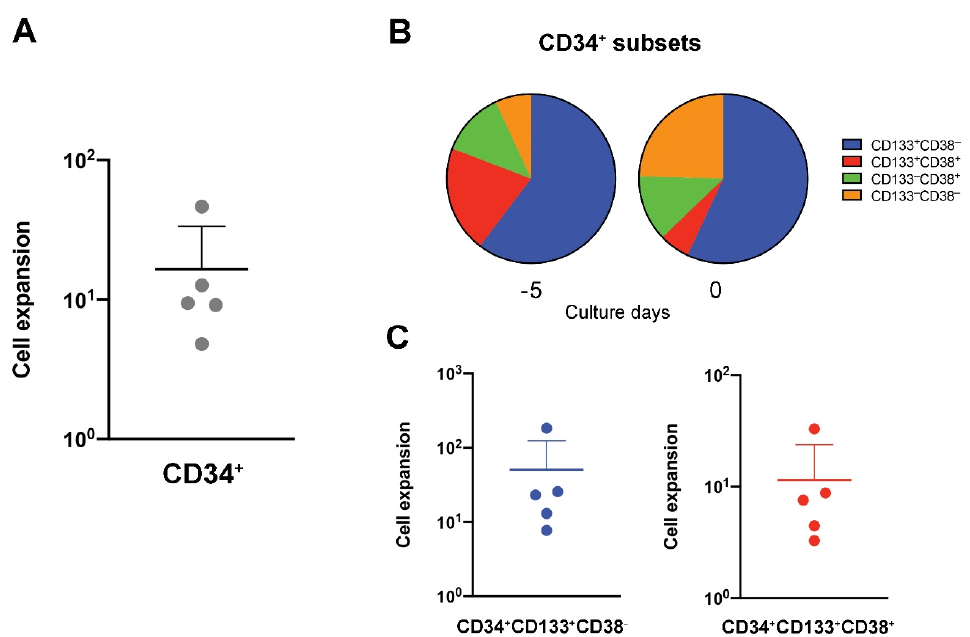
Figure 2. HSCs and their lymphoid progenitors are increased during expansion prior to T cell differentiation. UCB-derived CD34 + cells were isolated and expanded in CD34 Expansion media. ( A ) Fold change of total CD34 + cells, ( B ) population frequencies of CD133 and CD38 expression in the CD34 + population and ( C ) fold change of total CD34 + CD133 + CD38 − or CD34 + CD133 + CD38 + cells was determined after 5 days of culture. Cell number was determined using the TC20 cell counter and trypan blue staining. Individual data points represent independent biological samples; bars indicate the mean fold change ± SD. Colors represent individual cell subsets as indicated. CD133 + CD38 + cells decreased and CD133 – CD38 – increased proportionally over the five days (Figure 2B), with a 11.4-fold increase in the final number of CD133 + CD38 + cells (Figure 2C). This phenotype may have the potential to form granulocyte/monocyte pro- genitor cells as they are enriched in the CD34 + CD133 + CD38 + CD45RA + fraction [34]. How- ever, there is no clear evidence that suggests these cells lack T cell differentiation potential.